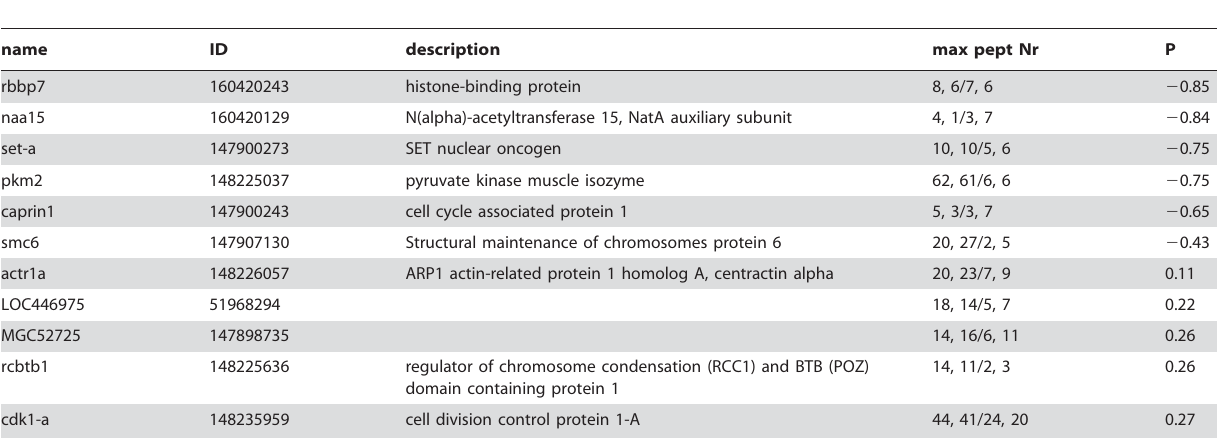
Table 1. Proteins with altered chromatin association dynamics in the absence of APC.